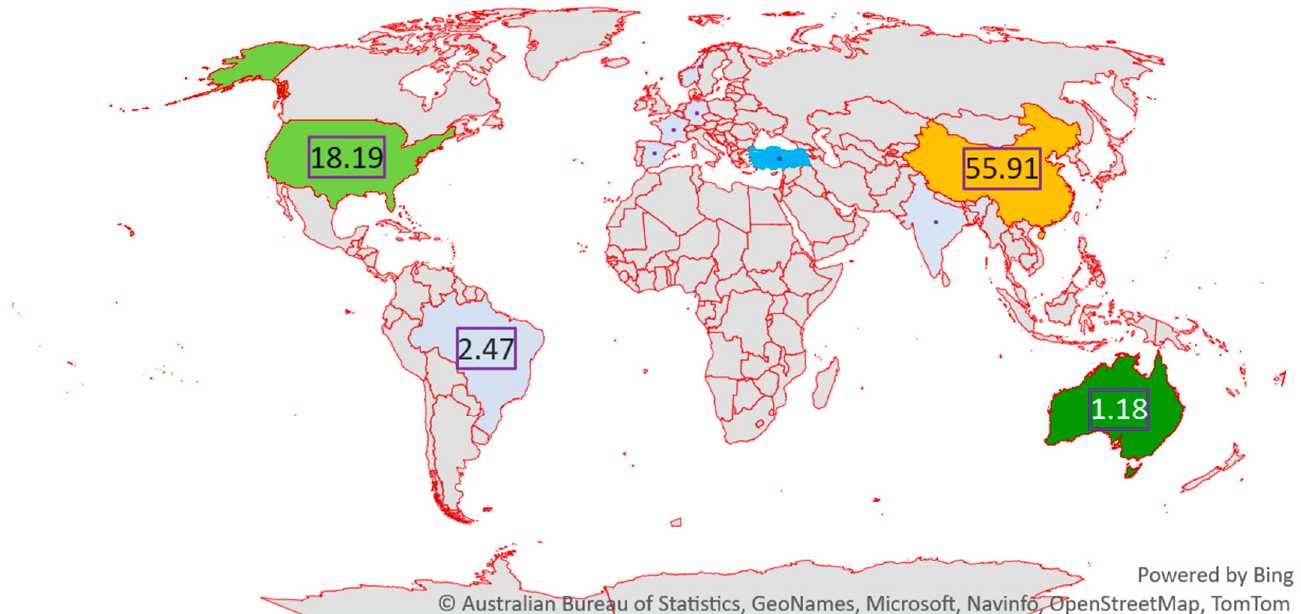
Figure 2. Global wind energy capacity and their respective